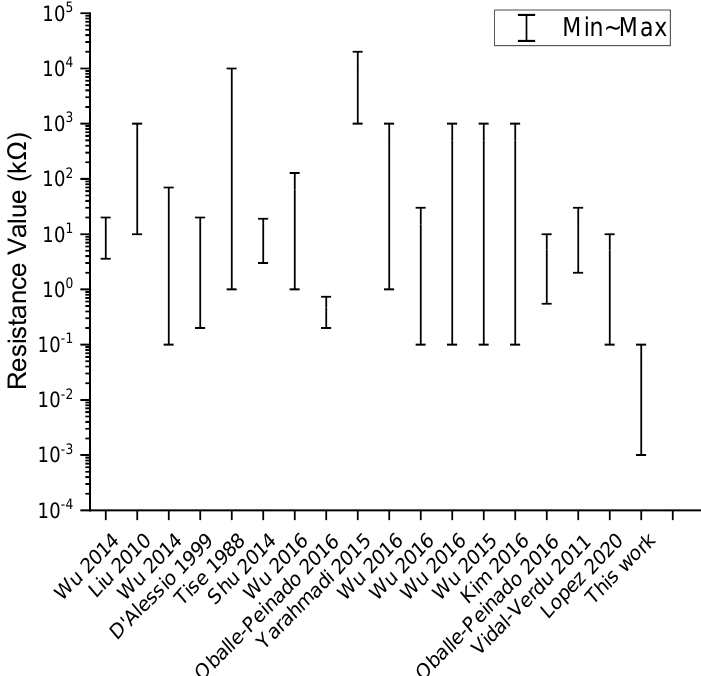
Figure 2. The range of resistance values addressed in different publications [14,15,16,17,19,21,24,25,27,28,29,30,33,34,36].